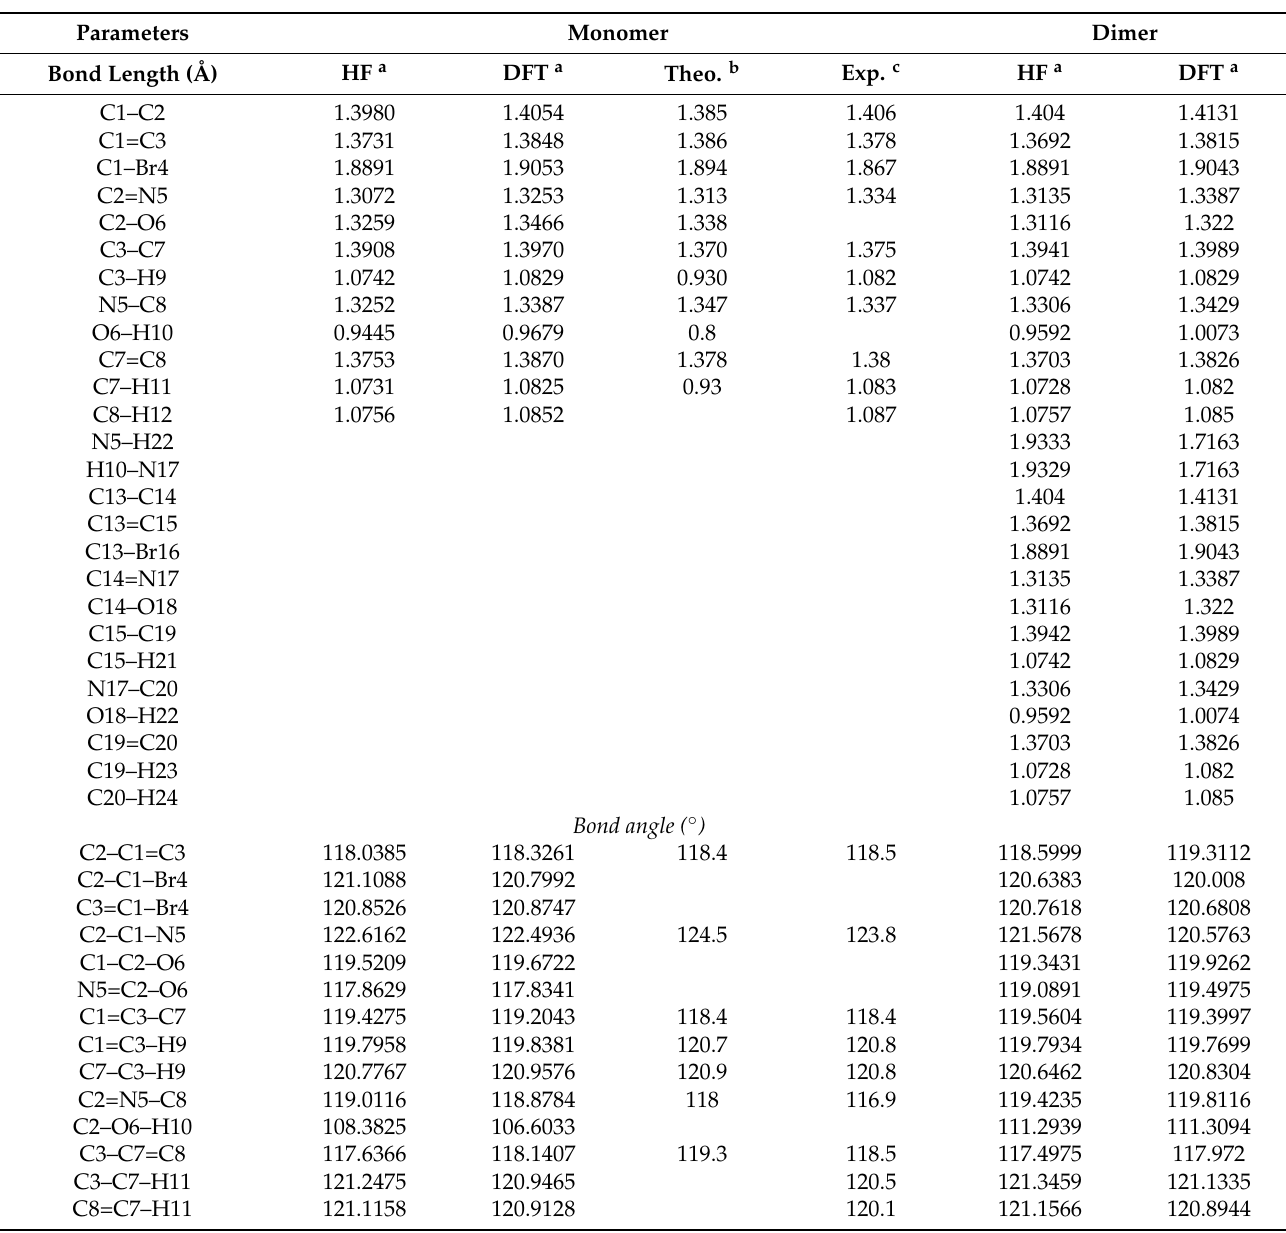
Table 1. Monomer and dimer geometrical parameters optimized in 3-Br-2-HyP (bond lengths (Å) and bond angles ( ◦ )) by both